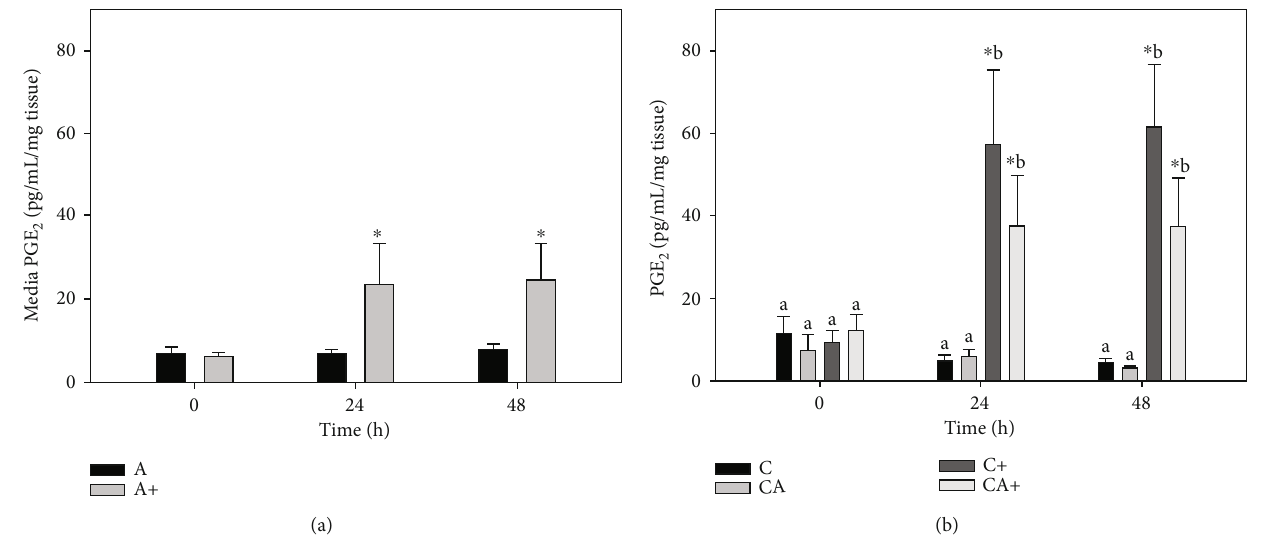
Figure 4: Prostaglandin E (PGE ) production by adipose tissue explants (a) and cartilage explants (C) cultured in the presence or absence of 2 2 adipose tissue explants (A) (b) with or without LPS (+; 10 μ g/mL). Data represent duplicate samples from 8 market-weight pigs. ∗ Denotes signi fi cant change from 0h within a single treatment group. Lowercase letters denote signi fi cantly di ff erent means at a single time point ( p < 0 : 05 ).